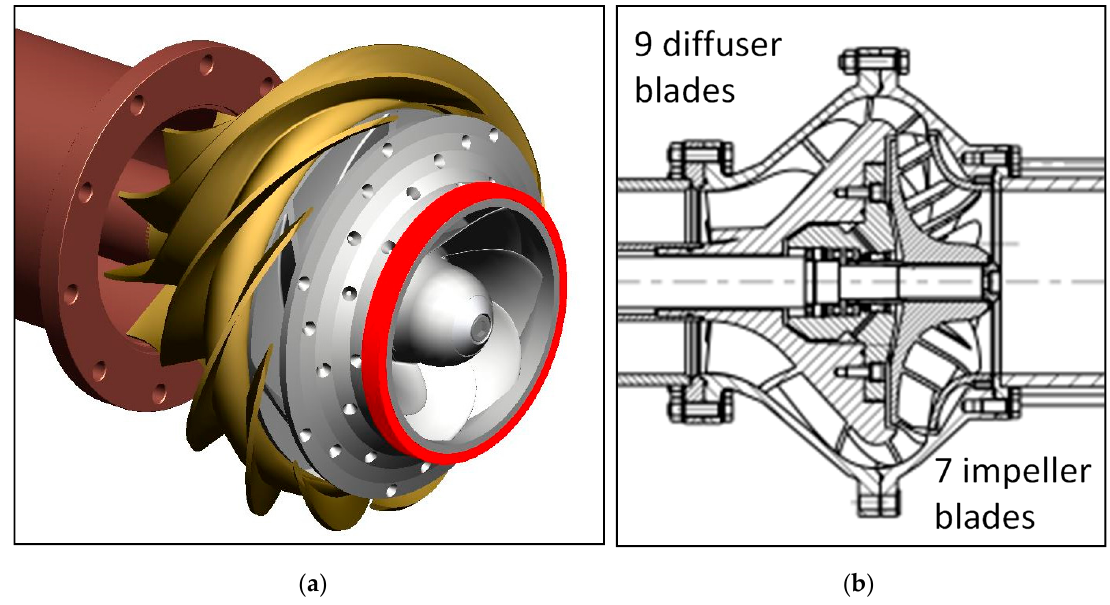
Figure 3. Investigated low-n q pump: isometric view ( a ) and meridional view ( b ).